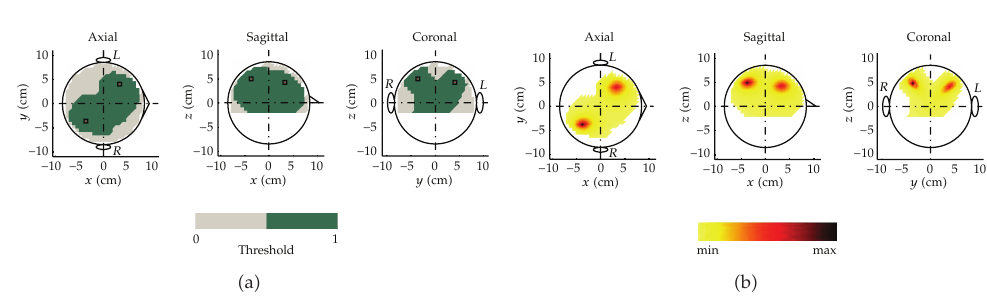
Figure 3: SNR (cid:8) 1: beamformer source reconstruction results using the ETWB strategy. (cid:2) a (cid:3) Reduced scanning region (cid:2) darker shaded region (cid:3) with a higher correlation value than the predetermined threshold value in (cid:2) 4.1 (cid:3) . (cid:2) b (cid:3) Beamformer source imaging in the region with reduced